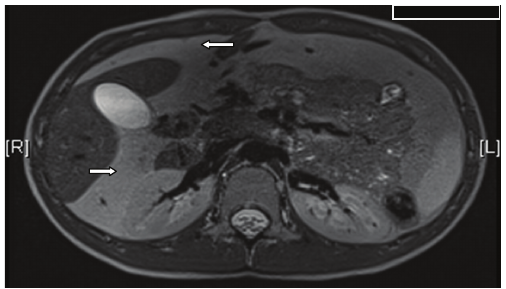
Figure 1: MRI abdomen: lipomatous tissue anterior to the liver and between the right lobe of the liver and the right kidney.